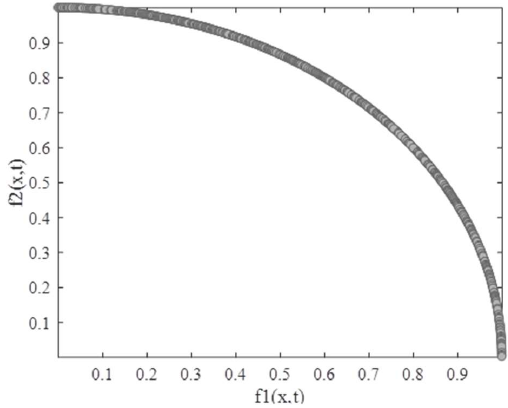
Figure 4. True Pareto front (PF) for f 1 ( x , t ) and f 2 ( x , t ).